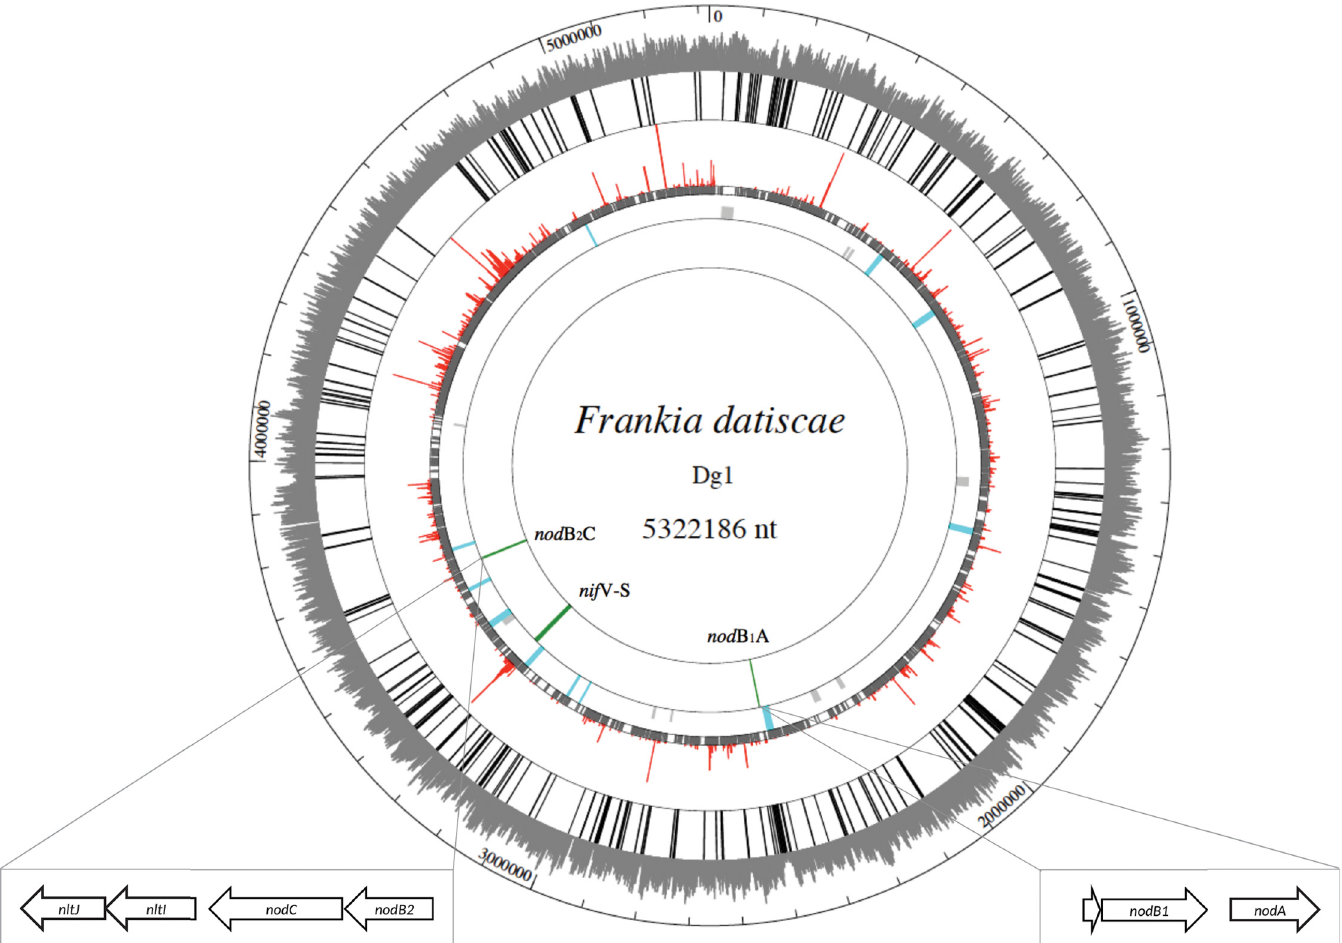
Fig 1. Circular map of the Dg1 genome. The outer circle shows the GC content (above 50%), the next circle shows the positions of IS elements (for detailed positions, see S2 Table). The next circle shows the results of mapping the transcriptome of a closely related cluster II strain on the Dg1 genome: the red peaks represent the genes expressed in the top 5% of expression levels, the grey peaks represent genes represented by at least one read per kb. The next circle shows the operons of genes encoding enzymes involved in the biosynthesis of secondary metabolites (S4 Table): blue color denotes genes which are represented in the symbiotic transcriptome, grey color operons that are not. The last circle shows the positions of the two operons of canonical nod genes ( nodA ’ B1A and nodB2C ) and the nif gene operon. The nod operons of Dg1 are depicted in detail. The nodA ’ B1A operon is at position 2,490,158 – 2,489,200 of the genome, the nodB2C operon at position 3,662,361 – 3,664,562. The latter is followed by the nltIJ genes at position 3,664,716 –